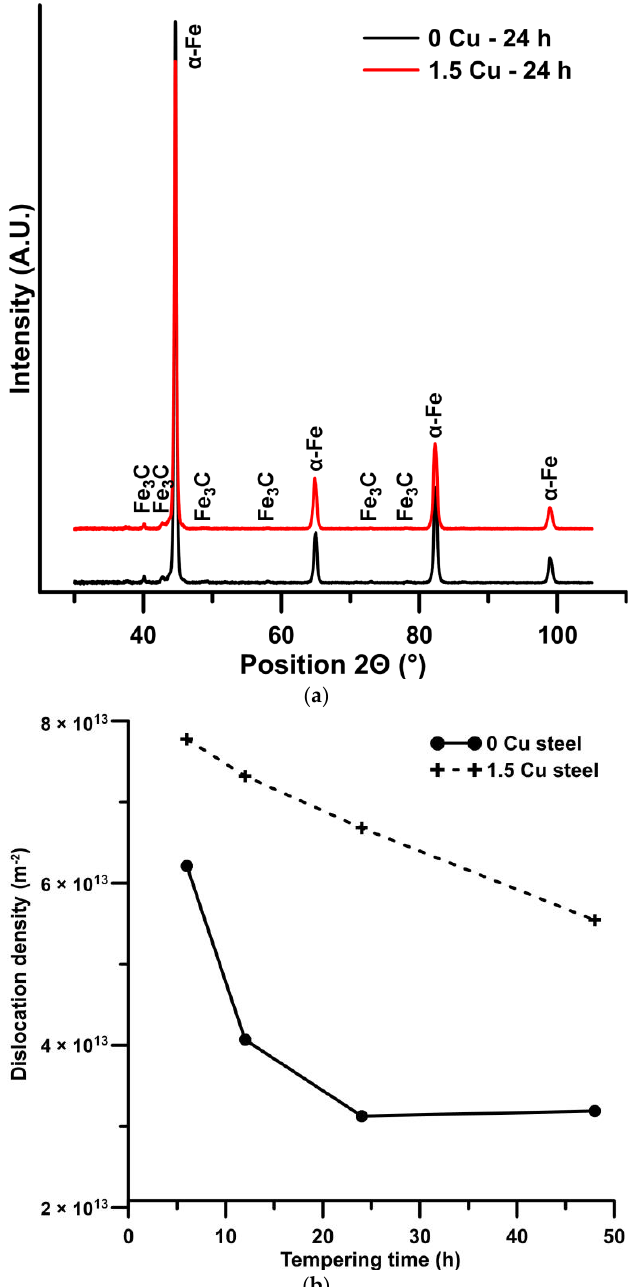
Figure 9. XRD patterns of 0 Cu and 1.5 Cu samples after tempering at 500 °C for 24 h ( a ) and dislocation density evolution during tempering at 500 °C ( b ).